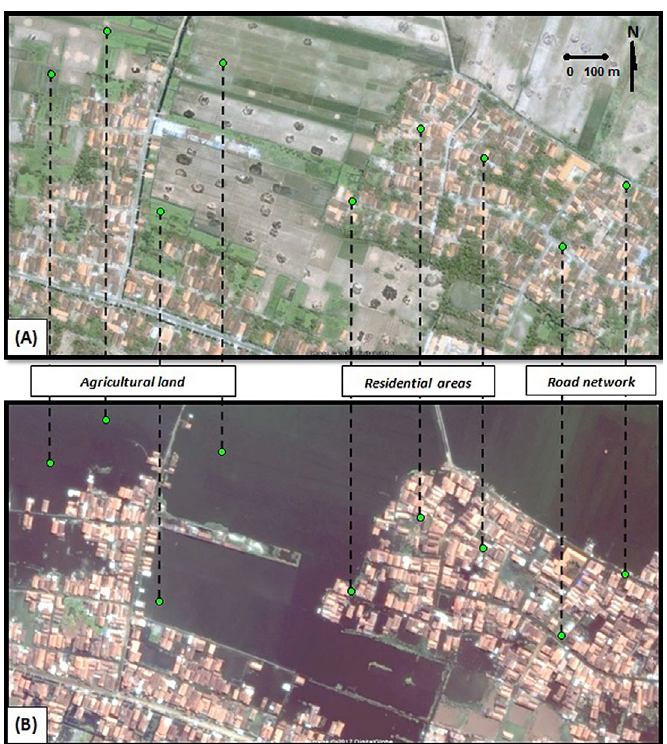
Fig. 12. Areas affected by flooding, such as agricultural land, residential areas and road networks in Jeruksari Village, Tirto District, Pekalongan Regency. (Source: Google Earth; CNES (the French space agency)). A. Environmental conditions pre-tidal flood, 22 October 2006; B. Flooded conditions during/post-tidal flood, 28 April